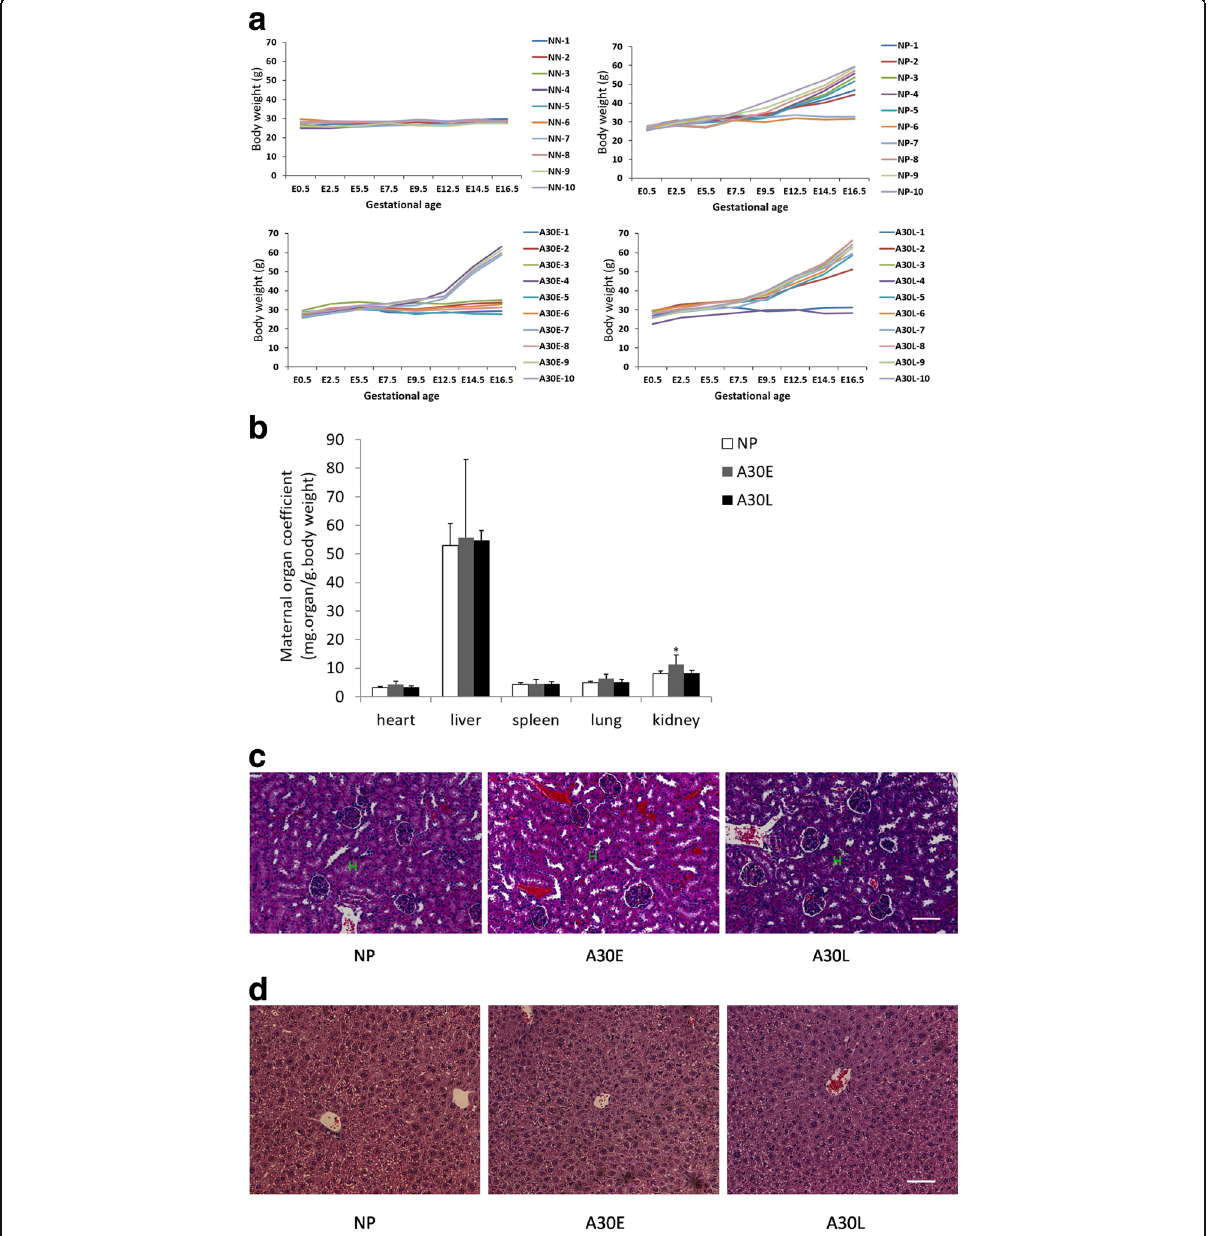
Fig. 4 Maternal physiological changes under exposure to A30 during early or late pregnancy. a The rate of increased weight of pregnant mice. NN is defined as normal non-pregnant mice. b Organ coefficient of pregnant mice. Data are shown as mean±s.d. (n=10 per group). The symbol * represents p <0.05 compared with NP group by ANOVA with Tukey ’ s test post-hoc. c H&E staining of maternal kidney of pregnant mice. d H&E staining of maternal liver of pregnant mice. For ( c ) and ( d ), representative images of at least 4 samples for each group are shown. The scale bar is 50 μ M